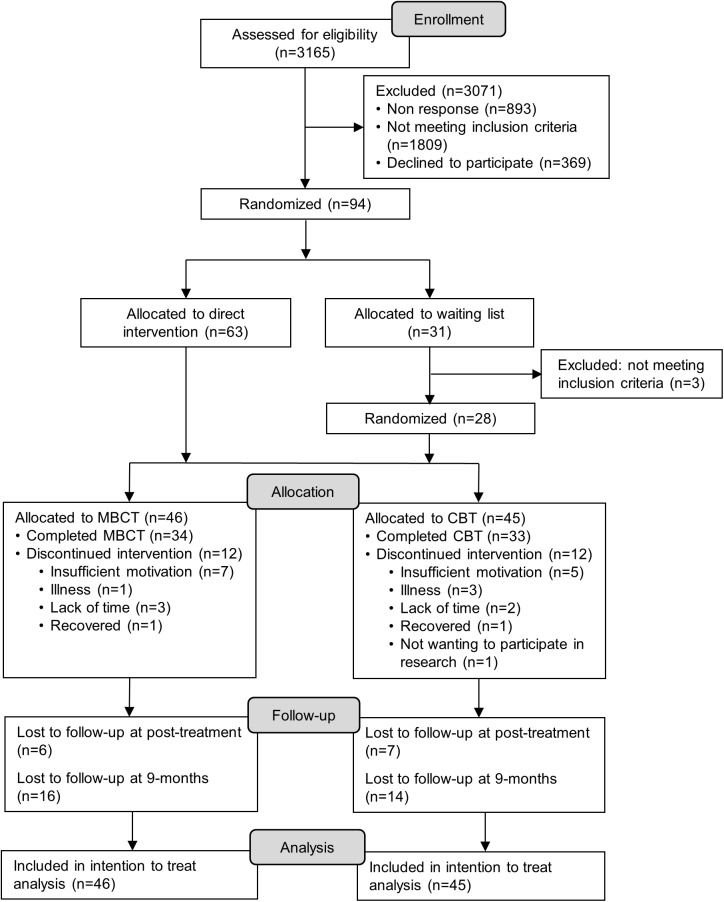
Flow of the study.